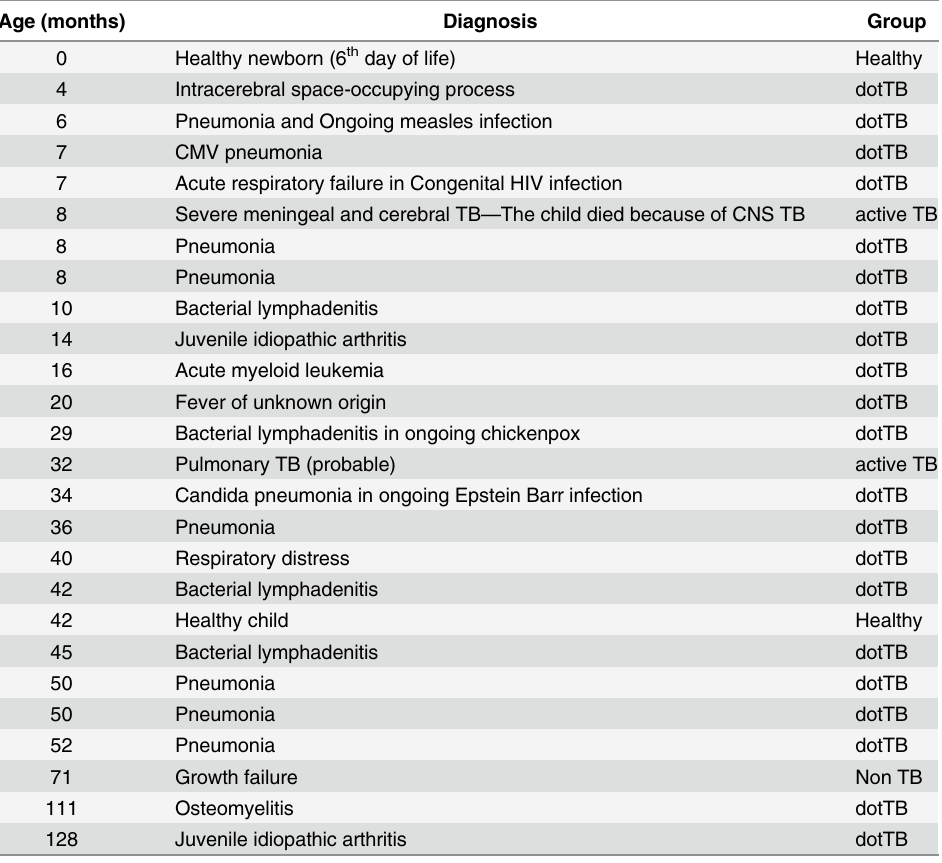
Table 5. Clinical characteristics of the children scored indeterminate to